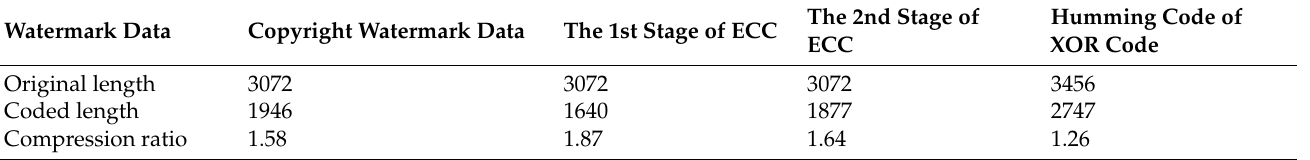
Table 6. Statistical results of compression coding.